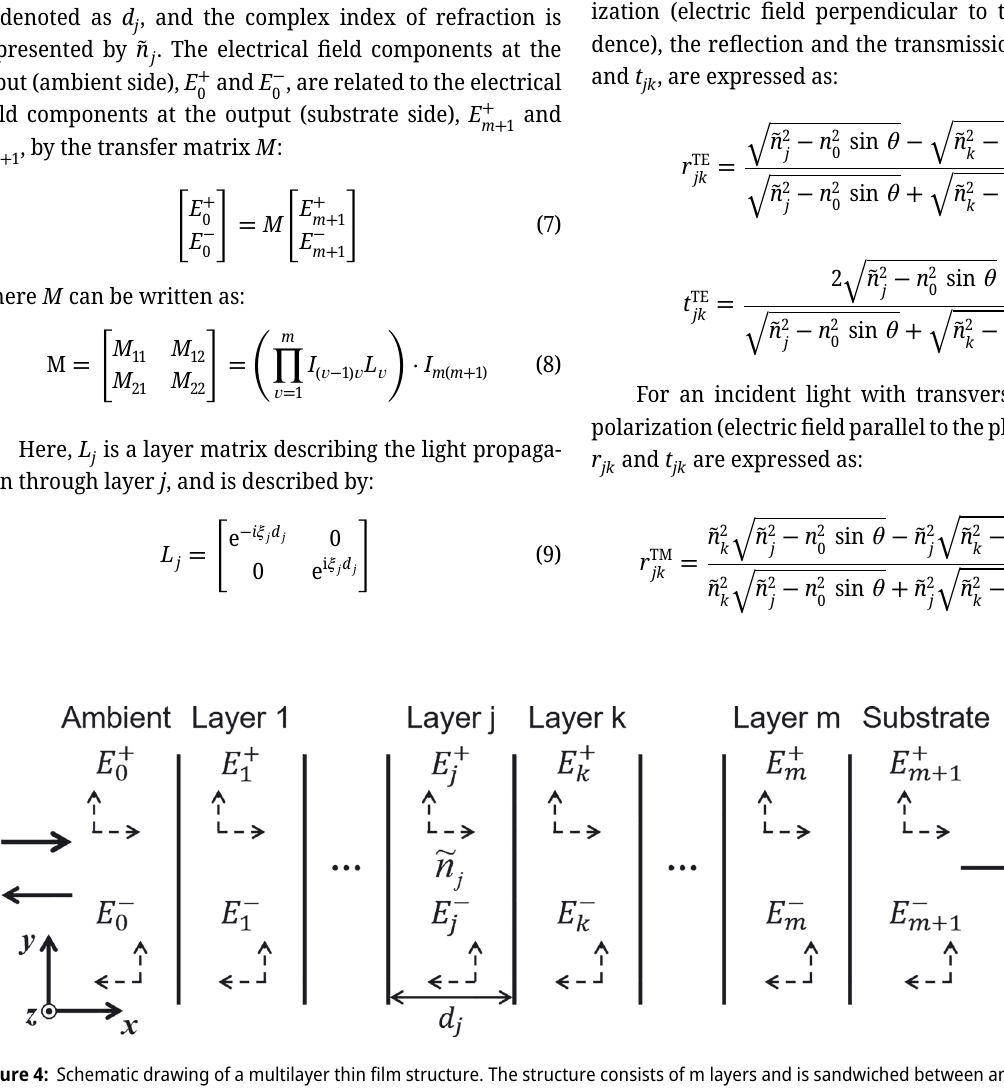
Figure 4: Schematic drawing of a multilayer thin film structure. The structure consists of m layers and is sandwiched between an ambient environment (layer 0) and a substrate (layer m + 1), both of which are considered to be semi-infinite. For layer j inside the thin film stack, its thickness and the complex index of refraction is represented by ̃ n . The electrical field components propagating along the + x and − x directions is denoted as d j j and E − , respectively. I represents the incident intensity, R and T , respectively denote the reflection and transmission intensity. are denoted as E + j j Modified with permission [92]. Copyright 1999, American Institute of